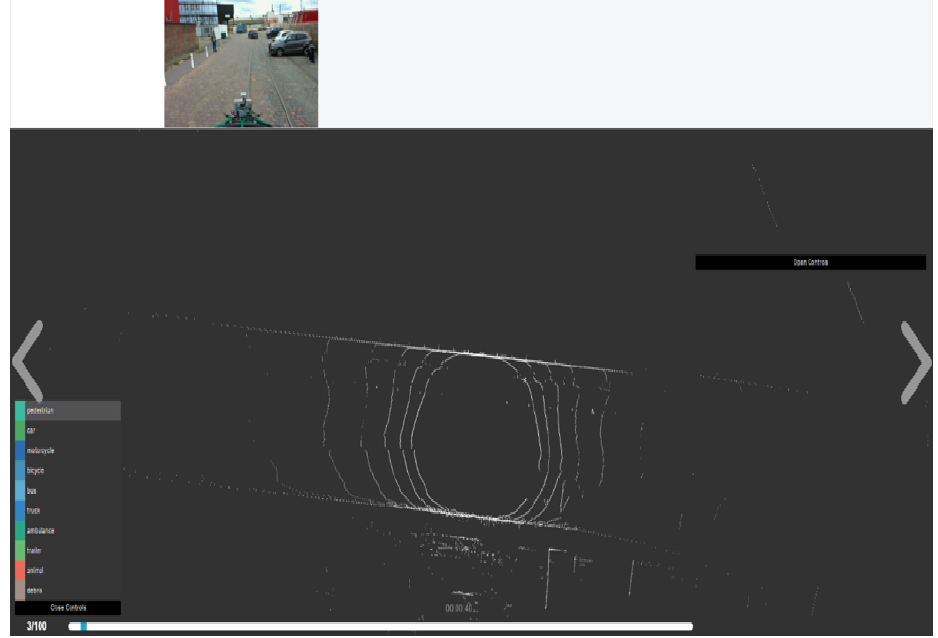
Figure 12. BAT 3D interface with one front image view tacked from our dataset in Le Havre